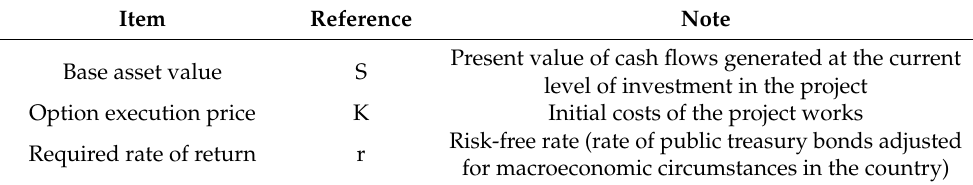
Table 1. Required information for the assessment of the present value of real